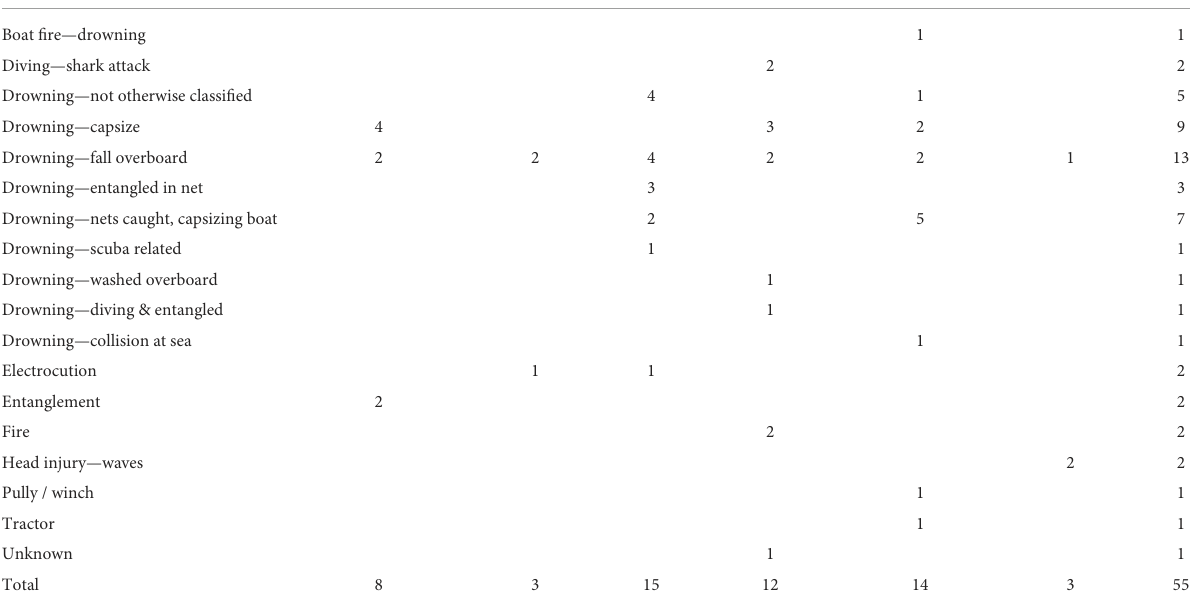
TABLE 2 ACFI fatalities by mechanism of injury 2003–2013 [Data from (31)]. Mechanism of